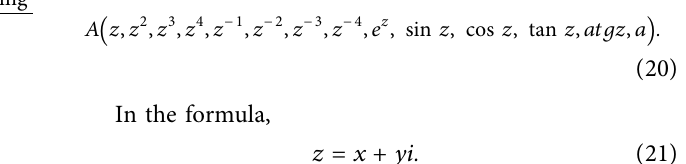
Table 2: Users’ scoring of works. Design art